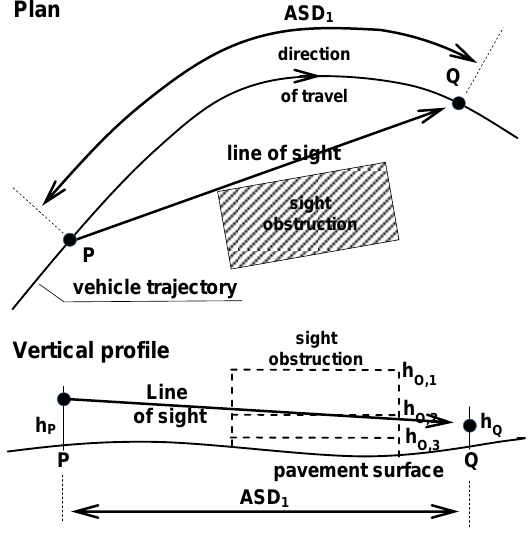
Figure 1. 3D estimation of ASD in a road